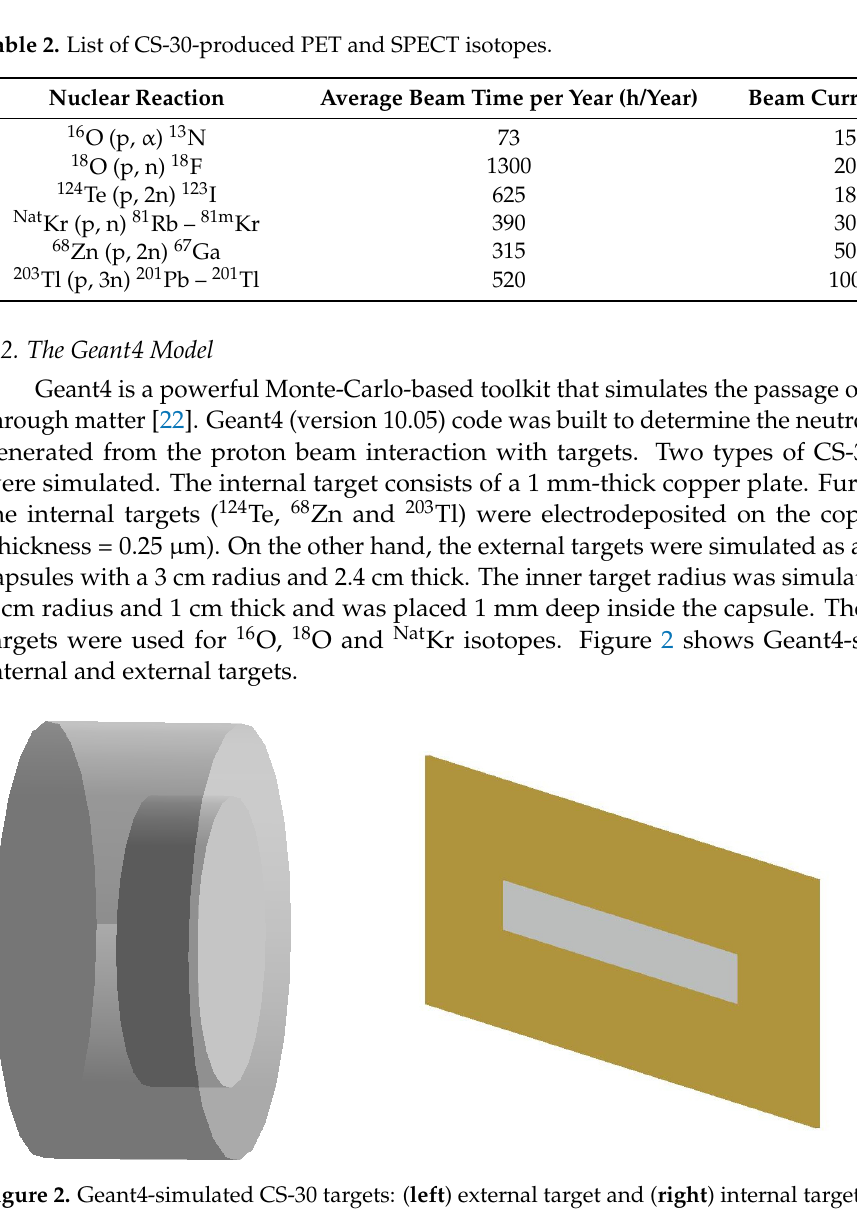
Figure 2. Geant4-simulated CS-30 targets: ( left ) external target and ( right ) internal Figure 2. Geant4 - simulated CS-30 targets : ( left ) external target and ( right ) internal target. The proton beam was simulated as a monodirectional point source of 26.5 MeV with